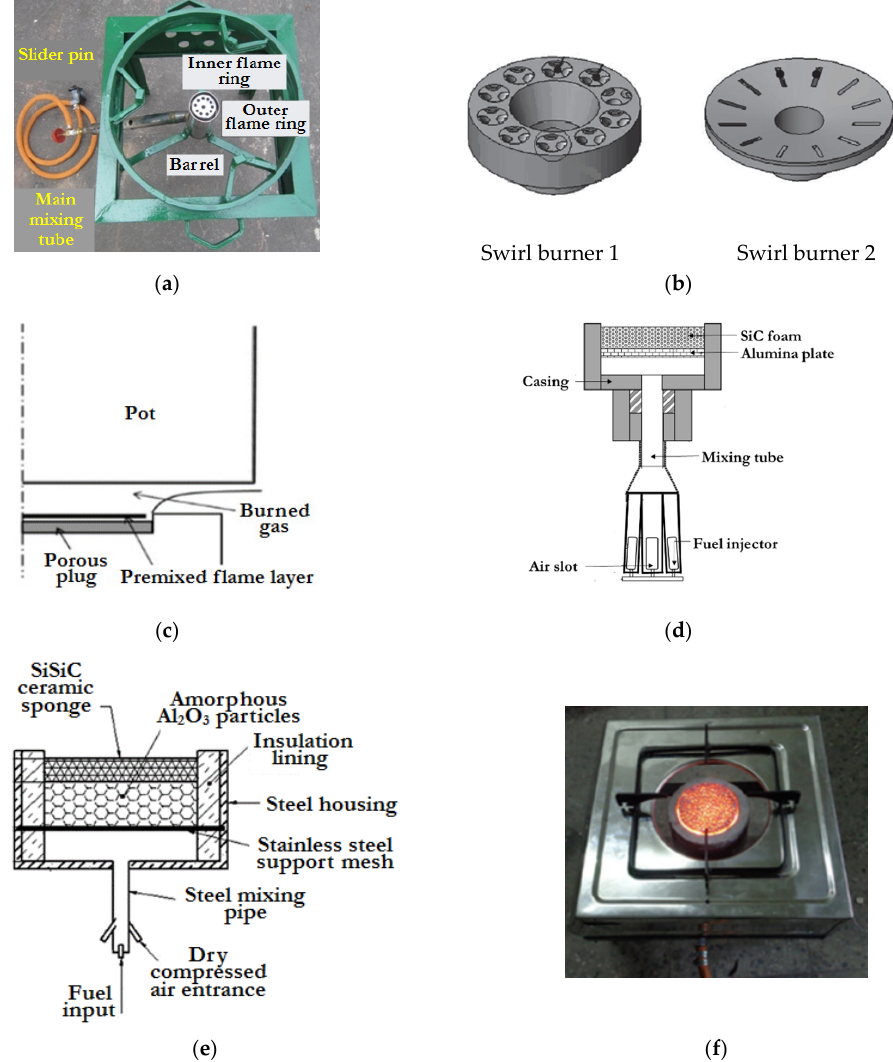
Figure 8. Improved LPG cook-stoves. ( a ) Improved cook-stove developed by Venture centre [35]; ( b ) Swirl burners developed by Zhen et al. [36]; ( c ) Porous metal burner developed by Wu et al. [40]; ( d ) Medium-scale PRB developed Mishra [41]; ( e ) Porous Radiant Burner developed by Herrera et al. [42]; ( f ) Domestic Porous Radiant Burner developed by Mishra and Muthukumar [43]. Table 1. Design features of improved LPG cook-stoves. S. No.